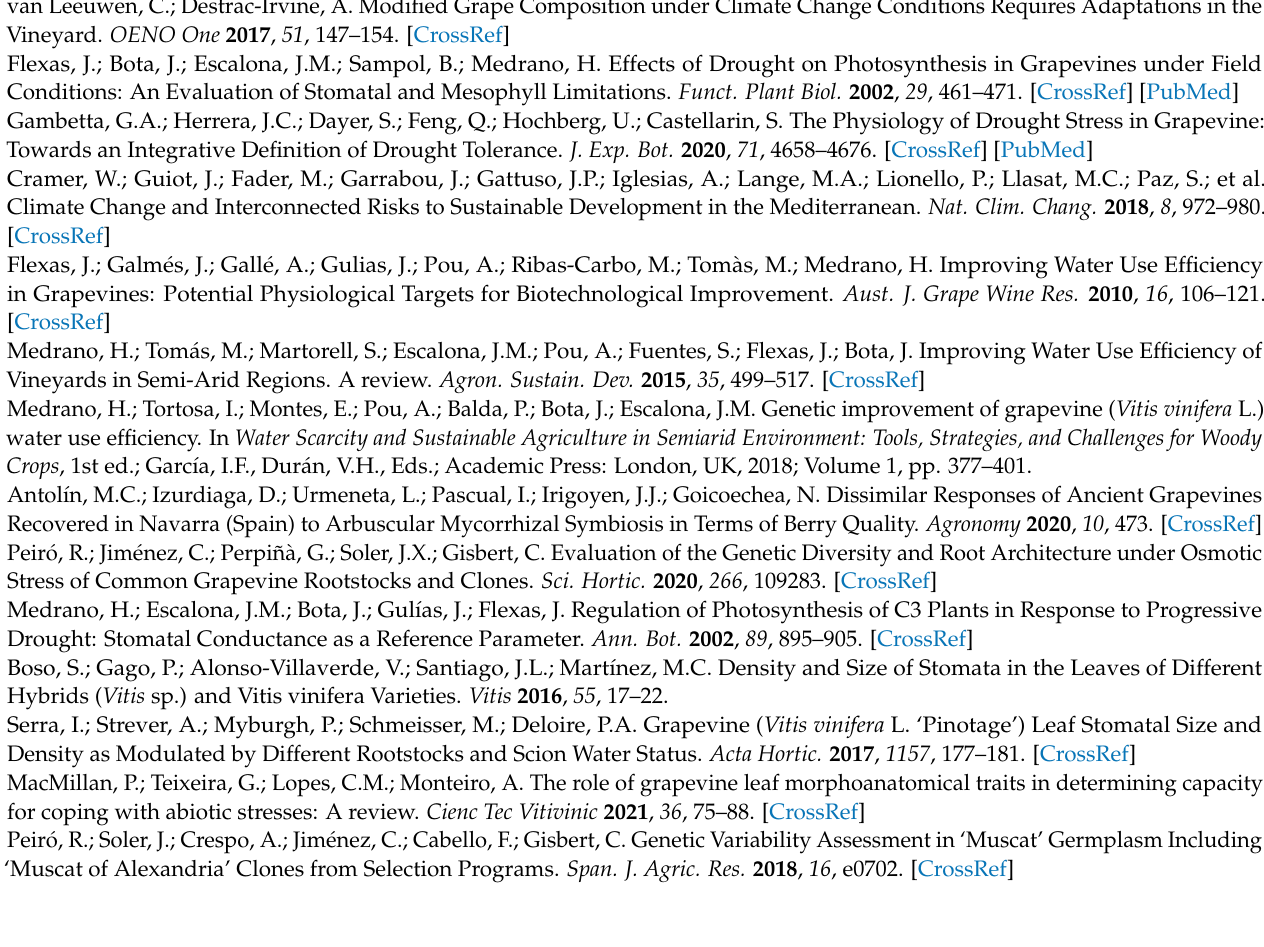
15 SSRs markers title; Table S3: Cielab color parameters for leaves of Arcos, Bobal, Forcallat, Garnacha, and